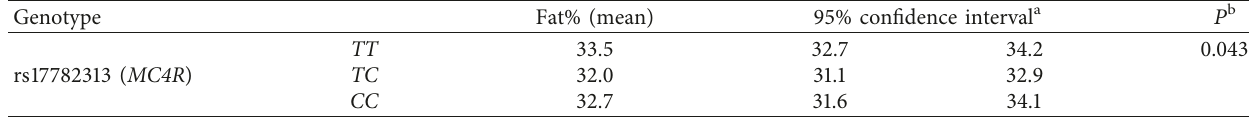
Table 2: The effect of the genetic variant close to the MC4R gene on dietary fat intake. Genotype